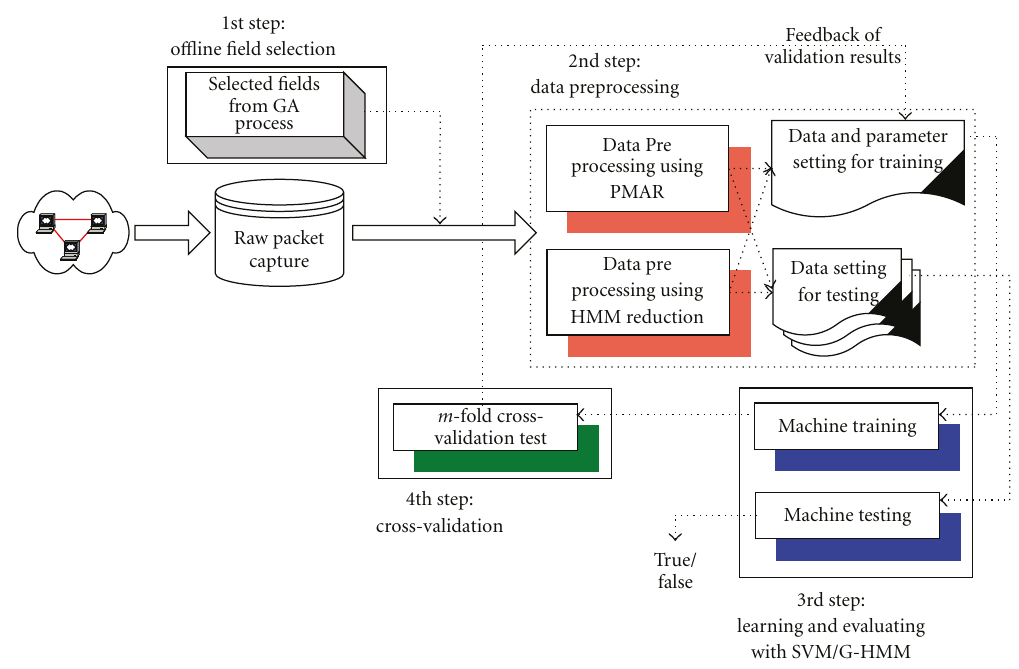
Figure 1: The overall structure of our proposed